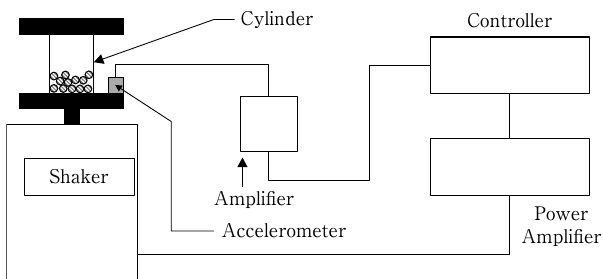
Fig. 1 Schematic of experimental